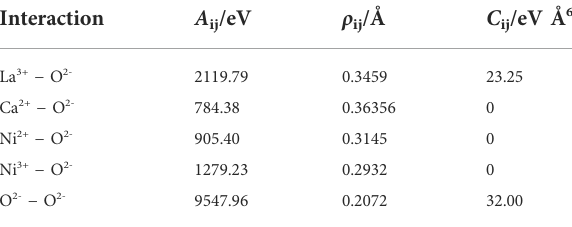
TABLE 1 Buckingham potential parameters (Minervini et al., 2000; Atkinson et al., 2003; Chroneos et al., 2010; Kitamura et al., 2020).